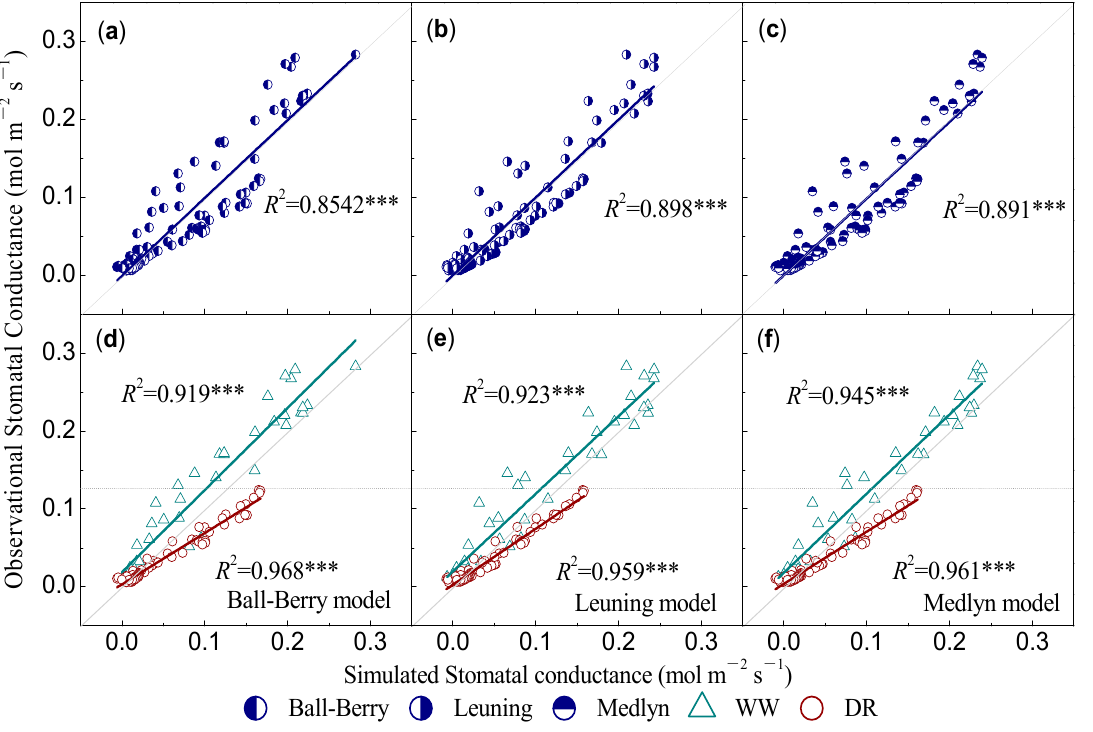
Figure 2. Relationships between observational stomatal conductance and simulated stomatal conductance by three different models, including ( a ) Ball-Berry model for whole data, ( b ) Leuning model for whole data, ( c ) Medlyn model for whole data, ( d ) Ball-Berry model under different water conditions, ( e ) Leuning model under different water conditions, and ( f ) Medlyn model under different water conditions. *** indicate significant level at 0.001. Ball-Berry, Leuning and Medlyn indicates the three typical stomatal conductance models. WW indicates leaf stomatal conductance for spring wheat under well-water condition. DR indicates leaf stomatal conductance for spring wheat when light-saturated stomatal conductance is smaller than 0.14 mol m − 2 s − 1